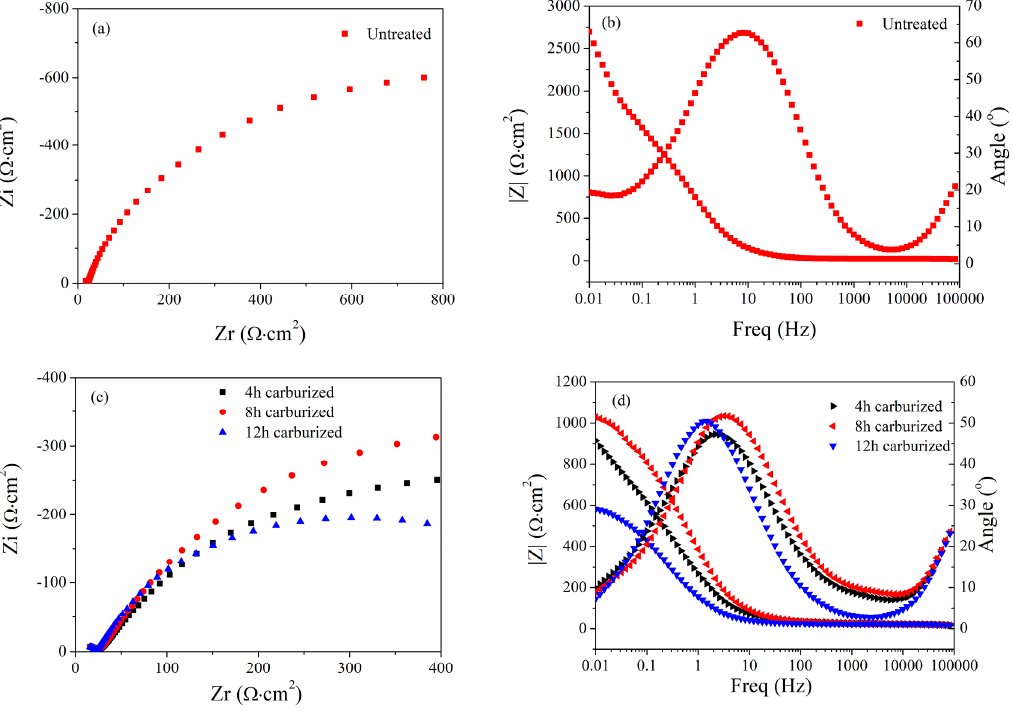
Figure 4. Nyquist and Bode plots of AISI 420 stainless steel. ( a , b ) Untreated specimen, ( c , d ) Carburized specimens. Table 2. Fitting parameter values for the untreated and the carburized AISI 420 stainless steel. CPE-P: dispersion index; CPE-T: double-layer